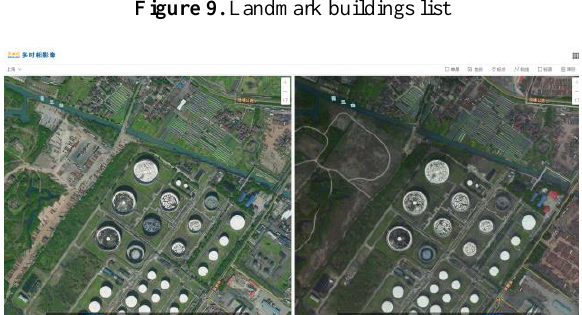
Figure 9. Landmark buildings list